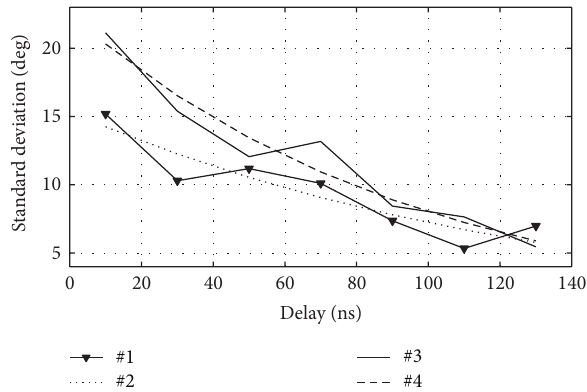
Figure 9: Standard deviations of empirical DOD (number 1) and DOA (number 3) elevations considered in a certain delay interval; number 2 and number 4 are their exponential fit,